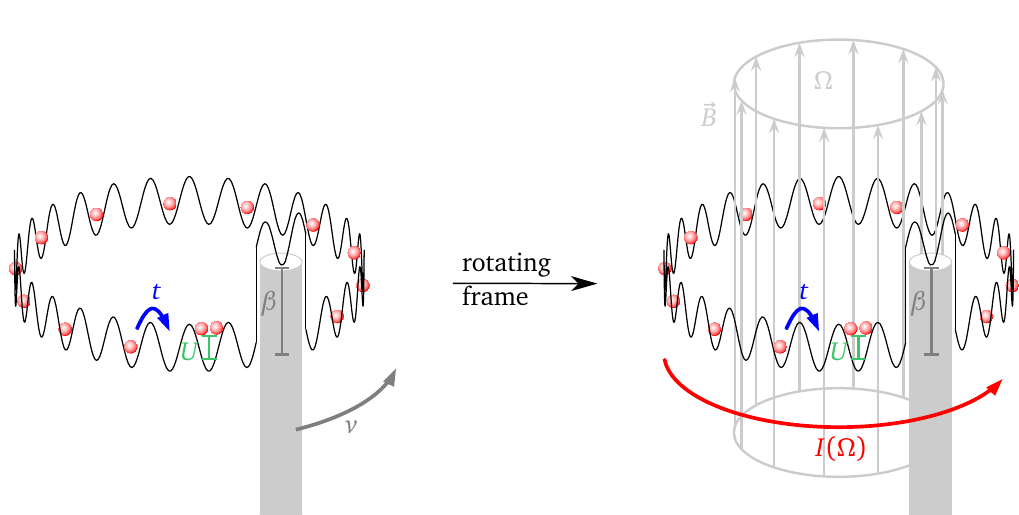
Figure 54: Sketch of a Bose–Hubbard ring with a barrier that rotates with a constant velocity v . In the rotating frame the barrier is at rest, but the bosons experience an (cid:126) B giving rise to a flux Ω through the ring, which leads to a boson artificial gauge field current I ( Ω ) ∝ ∂ E /∂ Ω